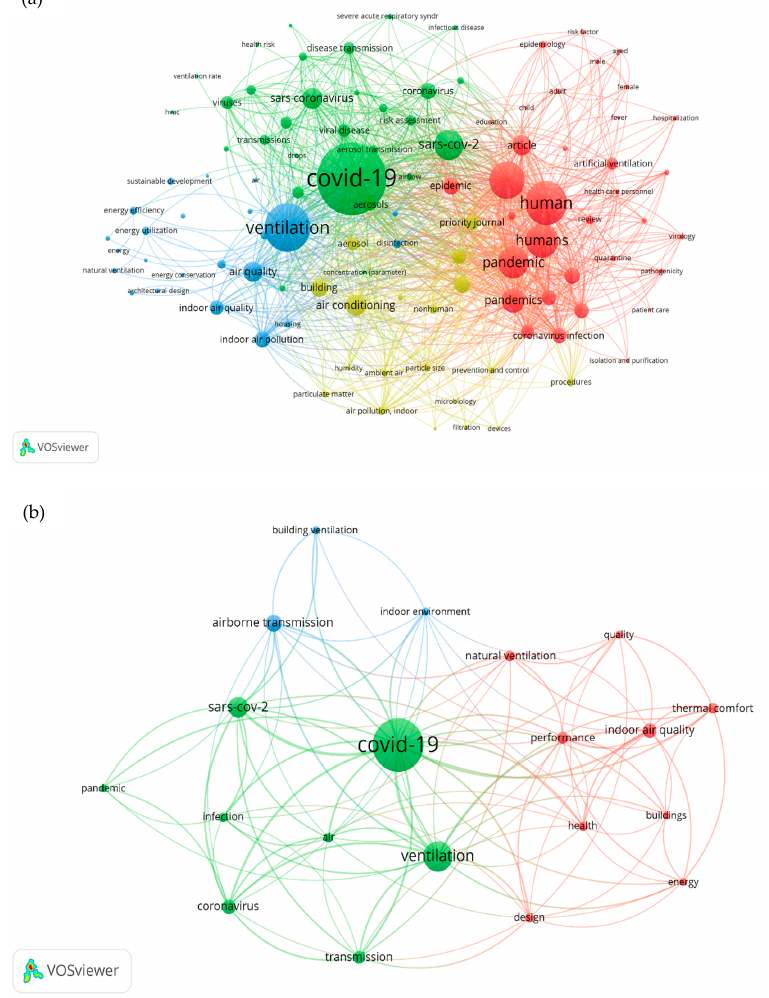
Figure 1. Network visualization based on keyword co-occurrence analysis: ( a ) Scopus data and ( b ) Web of Science data.